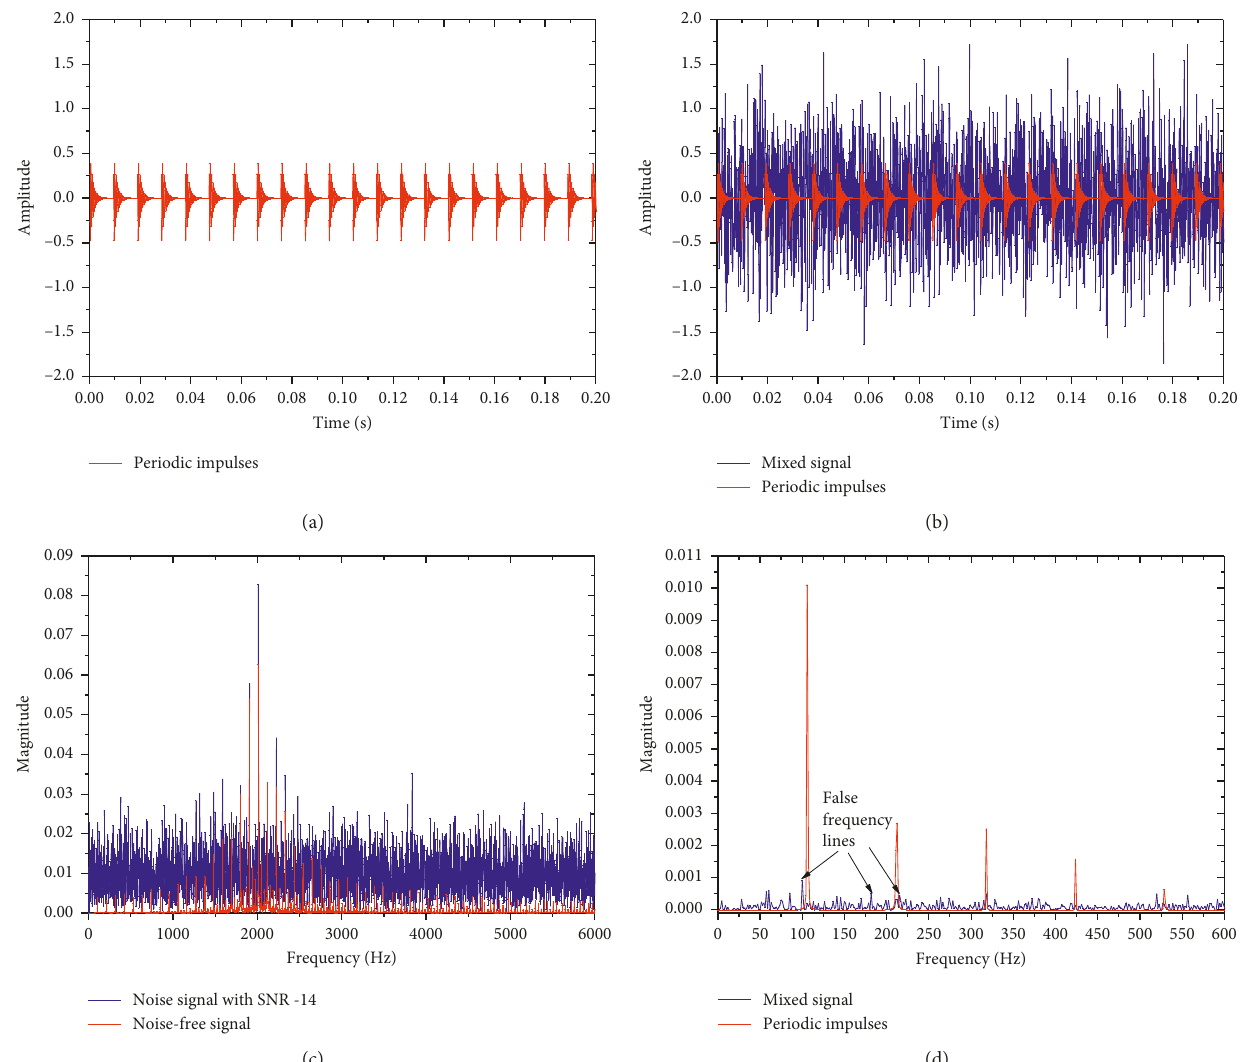
Figure 2: Simulation of the fault bearing vibration signal: (a) defect-induced periodic impulses; (b) the periodic impulses contaminated by noise; (c) frequency spectrums of pure periodic signal and noise-contained vibration signal; (d) squared envelope spectrums of the pure periodic signal and mixed